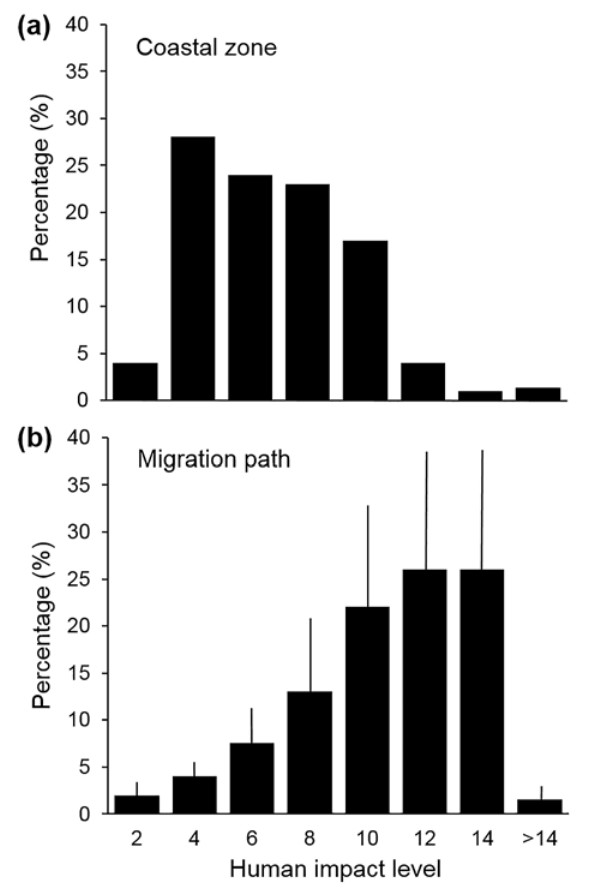
Fig 3. Threat level faced by East Pacific green turtles. (a) Histogram comparing the percentage of each threat level faced in the coastal area to the (b) actual average threat level faced by six migrating East Pacific green turtles (turtles A-F) migrating from Baja Californian foraging grounds to breeding grounds in Michoacán (n = 3) and from Michoacán breeding grounds to Central American foraging grounds (n = 3)